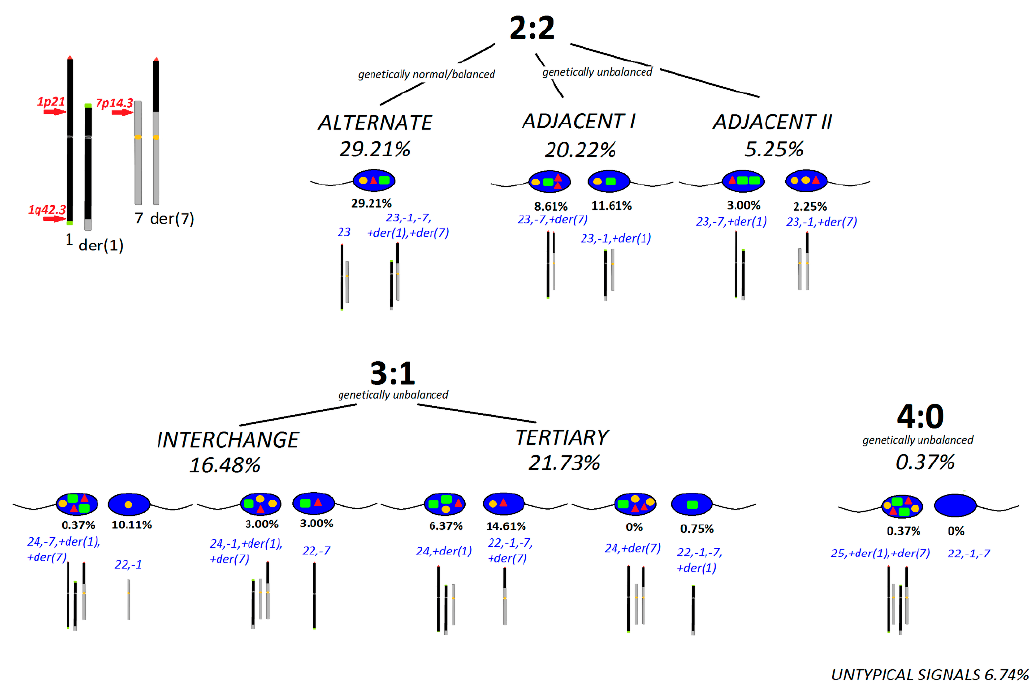
Figure 4. A schematic FISH representation of the labelling and frequency of particular segregation types for meiotic segregation pattern analysis performed for the spermatozoa of brother-2. FISH probes used: subtelomere specific for 1pter (red triangle), for 1qter (green square), and a centromere specific for chromosome 7 (yellow ellipse = red + green) (as described in the Materials and Methods section). The number of evaluated spermatozoa: n = 267.